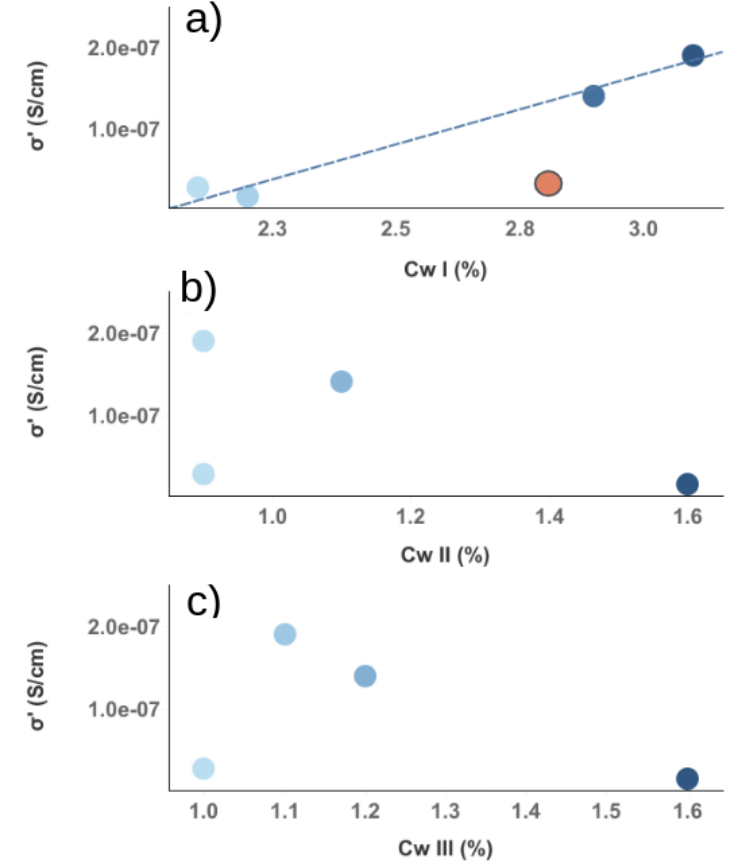
Figure 5. Electrical conductivity values at 100 Hz as a function of water population content. Gradient from light to dark blue refers to water content in 3D printed sample. In ( a ), the dashed line is a visual guide to highlight the linear dependence of conductivity with water population outgassing at a low temperature. In contrast, it is impossible to observe any dependence between conductivity and water amount considering the water population outgassing between 80 and 105 ◦ C ( b ) and the strongly bound water ( c